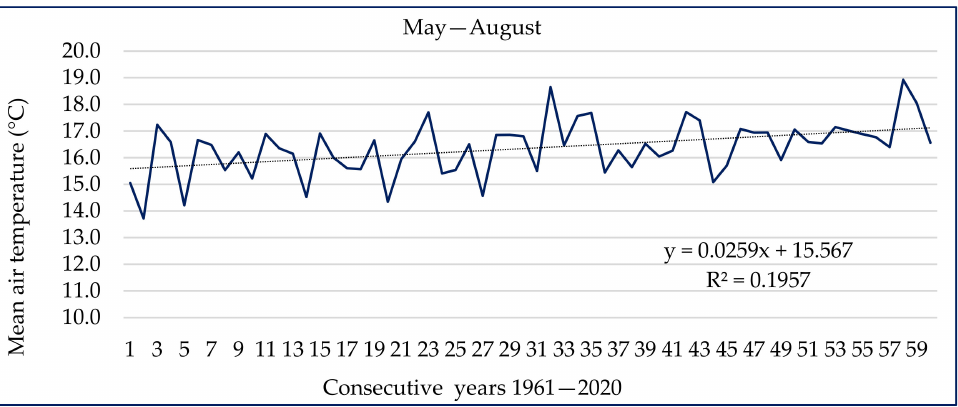
Figure 4. Variability over time of average air temperature ( ◦ C) during the period of active plant growth and development (May–August) in the region of Bydgoszcz in 1961–2020.